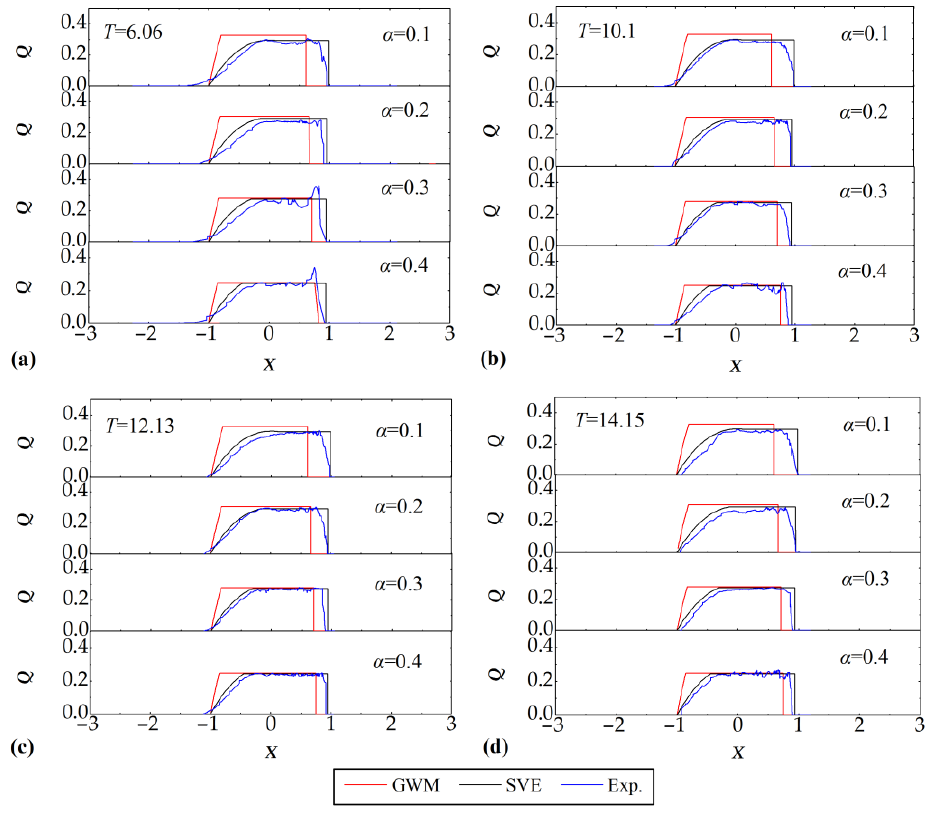
Figure 9. Flow discharge for wet bed downstream: ( a ) T = 6.06; ( b ) T = 10.1; ( c ) T = 12.13; ( d ) T = 14.15.